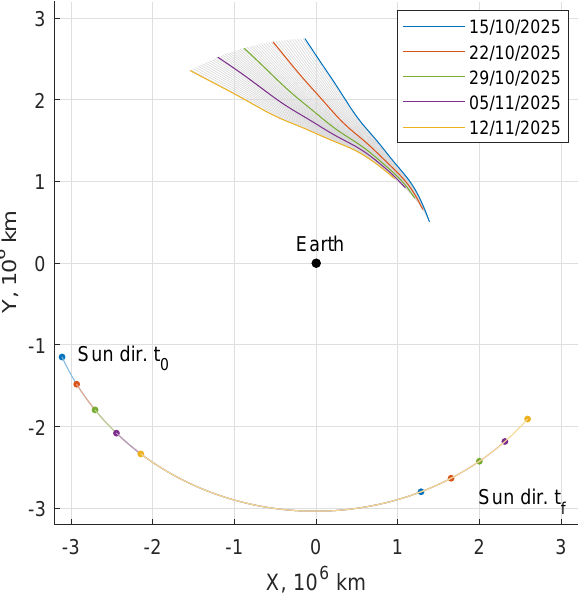
Figure 3. SEL2 escape trajectories over a lunar month, fixed t f = 90 days, free C 3 , EME2000 RF.